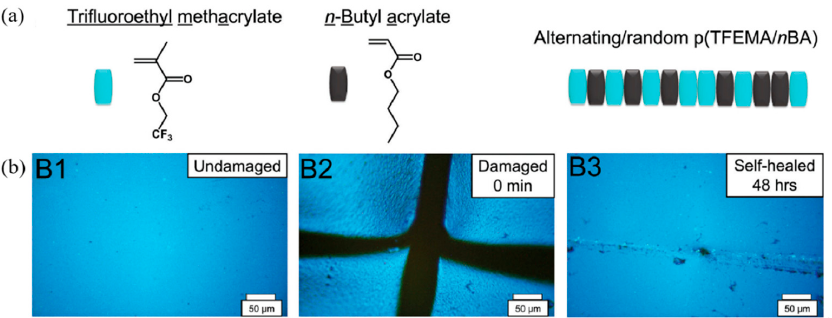
Figure 22. The self-healing process of fluorinated copolymers; ( a ) chemical structure of monomer in self-healing system; and ( b ) comparison of the optical images of undamaged, damaged, and healed samples [111]. Reprinted from [111], with permission from John Wiley and Sons.